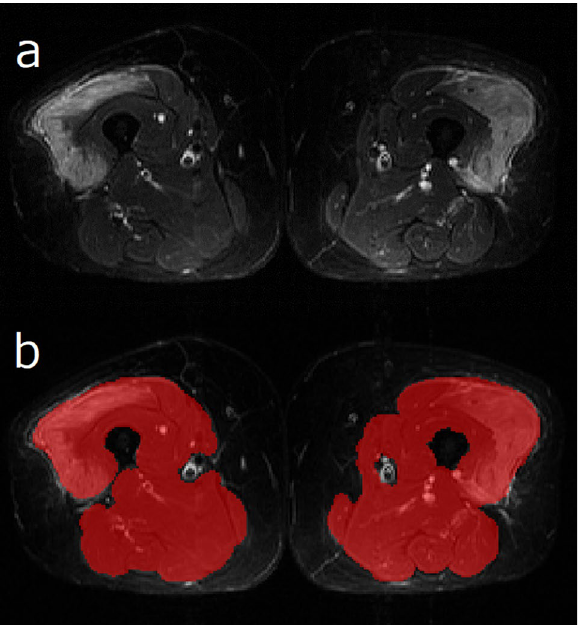
Figure 3. Representative segmentation style in a 67-year-old woman with PM. ( a ) An unenhanced STIR image of thigh muscles in the axial plane was examined. ( b ) The whole area of the muscles in the proximal thighs was segmented as a ROI (red shaded area), excluding the